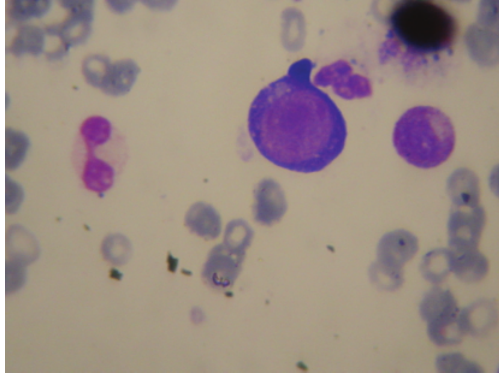
Figure 1: Bone marrow smear: proerythroblast with cytoplasmic